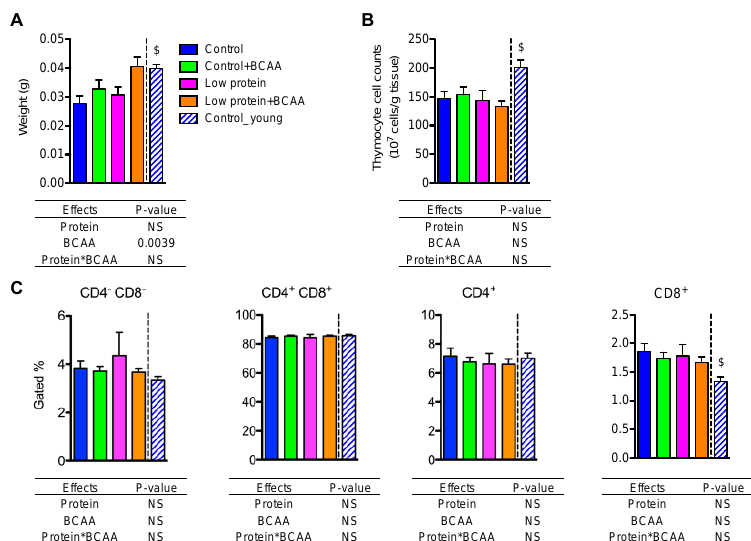
Figure 6. BCAA supplementation increased thymus weight but did not affect thymocyte cell counts or T-cell populations. Thymus weight was recorded at end of study ( A ), and thymocyte cell counts were calculated ( B ). The quantification of CD4 - CD8 - double negative, CD4 + CD8 + double positive, CD4 + single positive, and CD8 + single positive T-cell populations in the thymus ( C ). Data represent mean ± SEM ( n = 11–12 mice/group). Statistical analyses of main effects (protein and BCAA) and interactions (protein*BCAA) are shown below each graph. $ p < 0.05 for the young vs. old control groups.